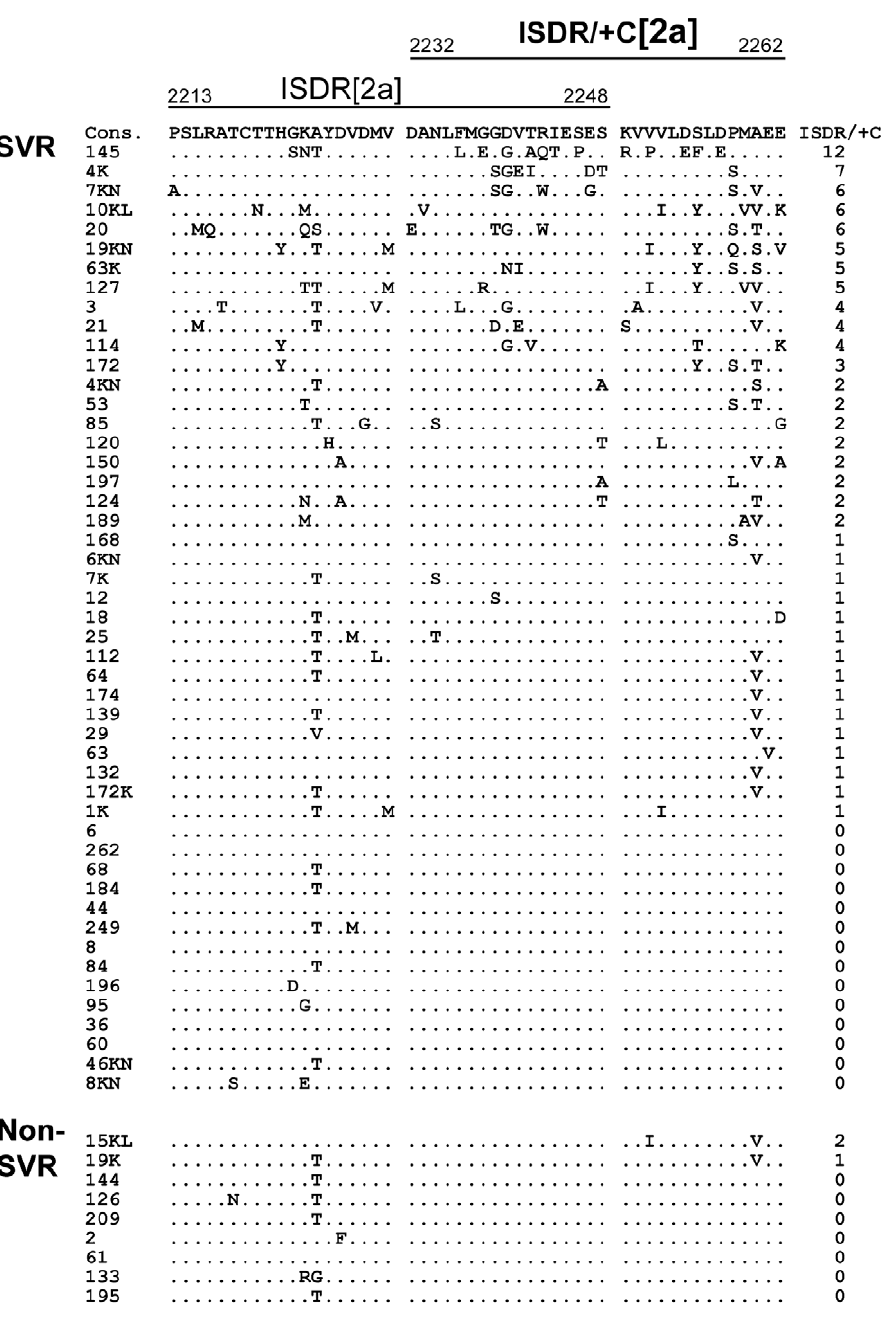
HCV core antigen titers than those infected with IRR- DR[2a] # 3. On the other hand, there was no significant difference in HCV viremia titers between ISDR/ + C[2a] $ 1 and ISDR/ + C[2a] = 0 (Figure 4B). Also, in HCV-2b infection, there was no significant difference in pretreatment HCV viremia titers between IRRDR/N[2b] $ 2 and IRRDR/N[2b] # 1 (Figure 4C).